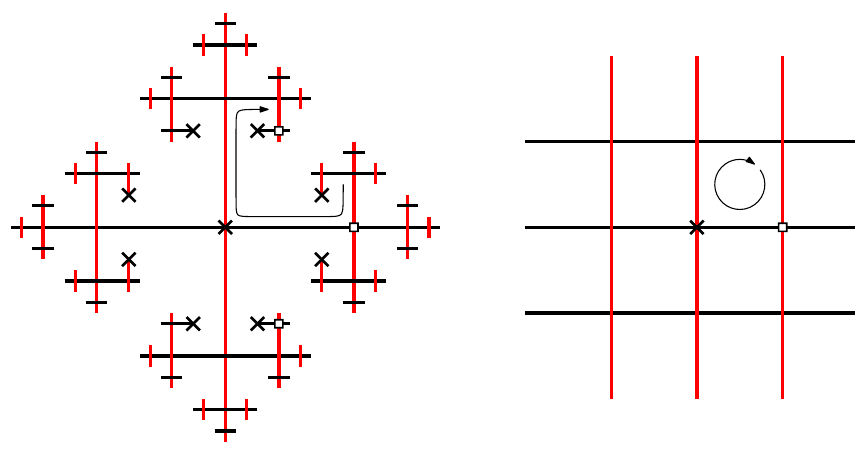
Figure 3 . The tree structure for square (cid:12)shnet models (left) can be depicted as a square (cid:12)shnet (right). Horizontal lines represent one (cid:12)eld species of (cid:12)eld in the theory, vertical lines represent the other, we can consistently consider them all oriented rightwards and upwards. The nodes of the tree we have marked with the same symbol are represented by the same (cid:12)shnet vertex. Wrapping once a tile of the (cid:12)shnet corresponds to jumping from a branch of the tree to the consecutive one. but any contraction between di(cid:11)erent blocks explicitly breaks the planarity of the